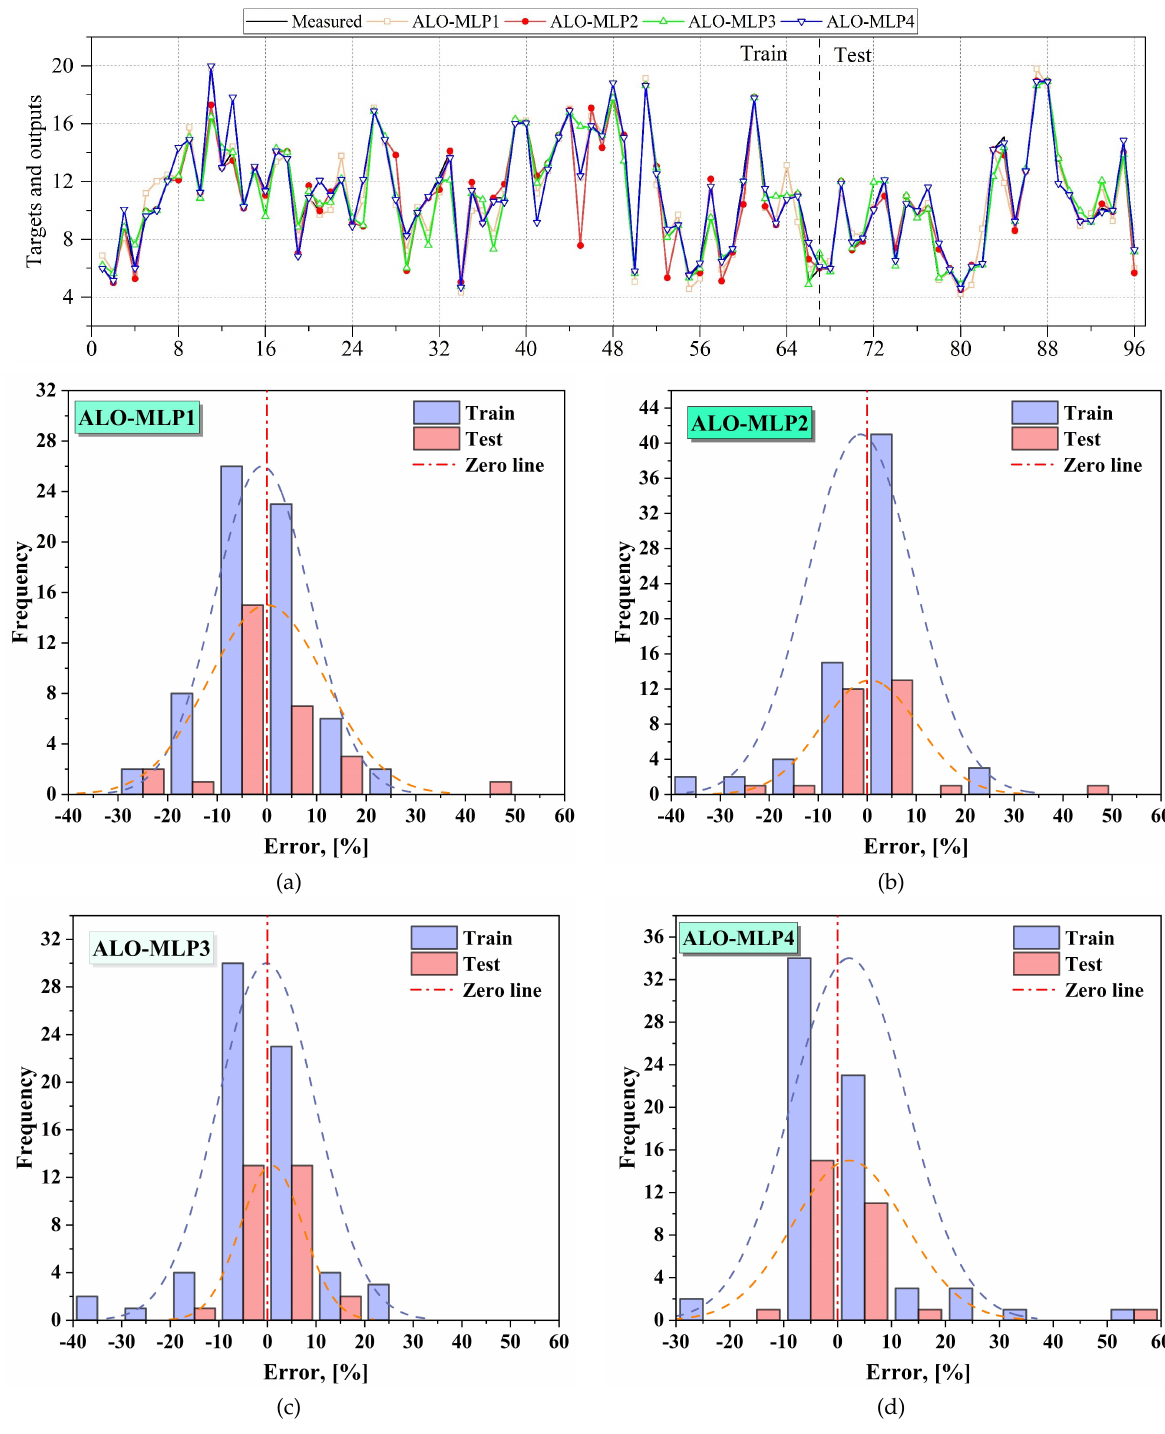
Fig. 10. Comparison between measured and predicted SP and error histogram for ALO-MLP